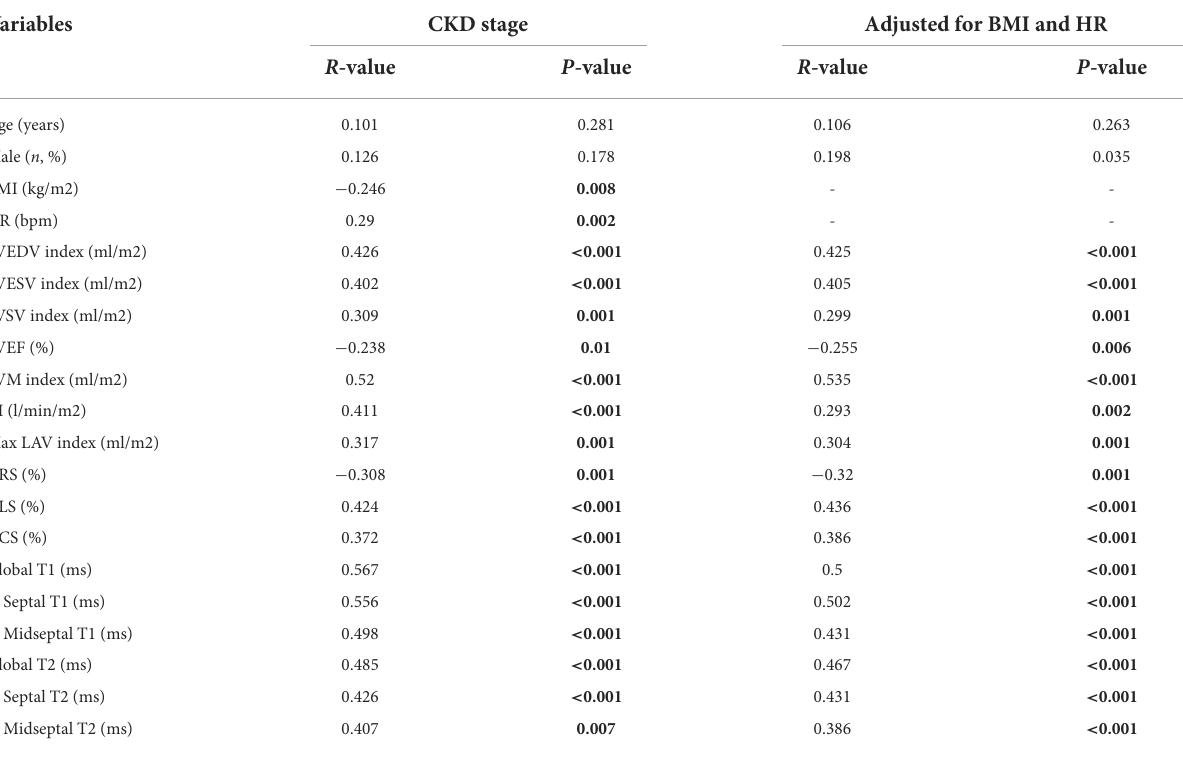
TABLE 4 Univariate correlation coefficients for worsening CKD